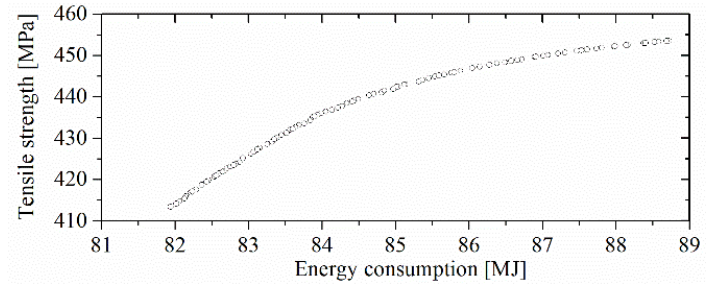
Figure 12. Pareto front of a set of solutions for the SLM process. Table 8. Comparisons of process parameters and optimized results for different scenarios of the SLM process.